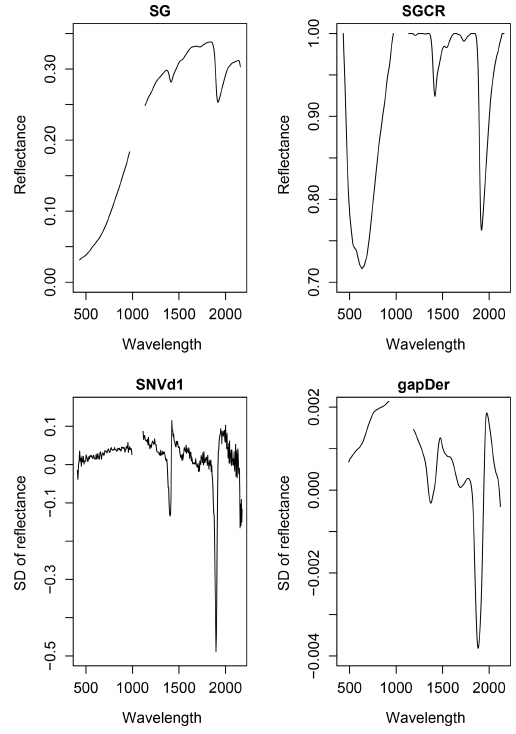
Figure 3. Impact of different pre-processing techniques on a spectrum; SG − Savitzky–Golay, CR − continuum removal, SNV − standard normal variate, d1 − 1st derivative, gapDer − gap- segment